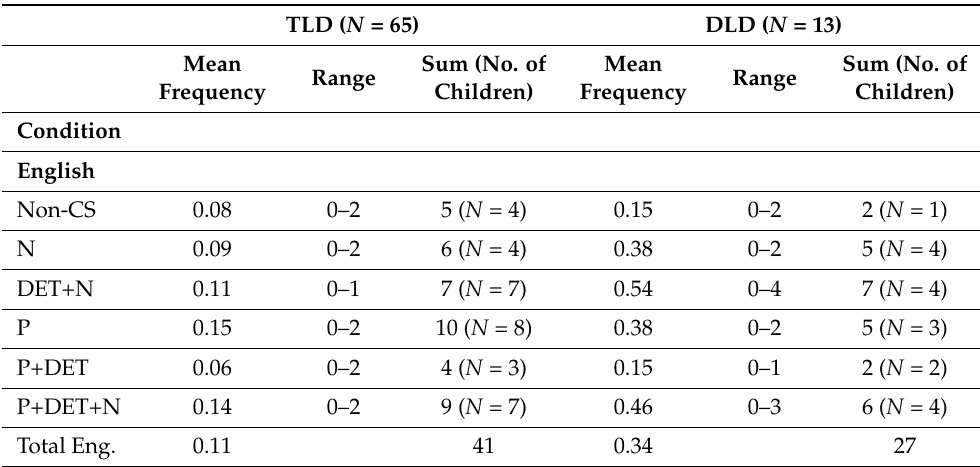
Table 2. Mean frequency, range, and sum of non-targeted CS for six CS conditions in English and Hebrew stimuli for children with TLD and